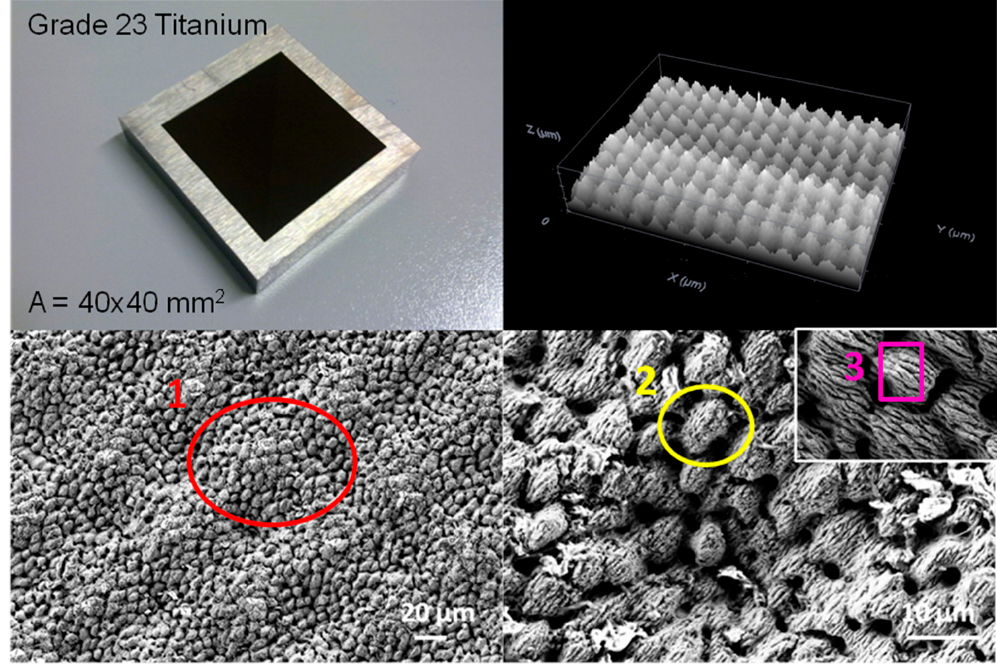
Figure 10. Hierarchical structures generated on Titanium Grade 23 by picosecond laser texturing: (1) Pyramidal structures; (2) Micro-humps; and (3) nanoripples.